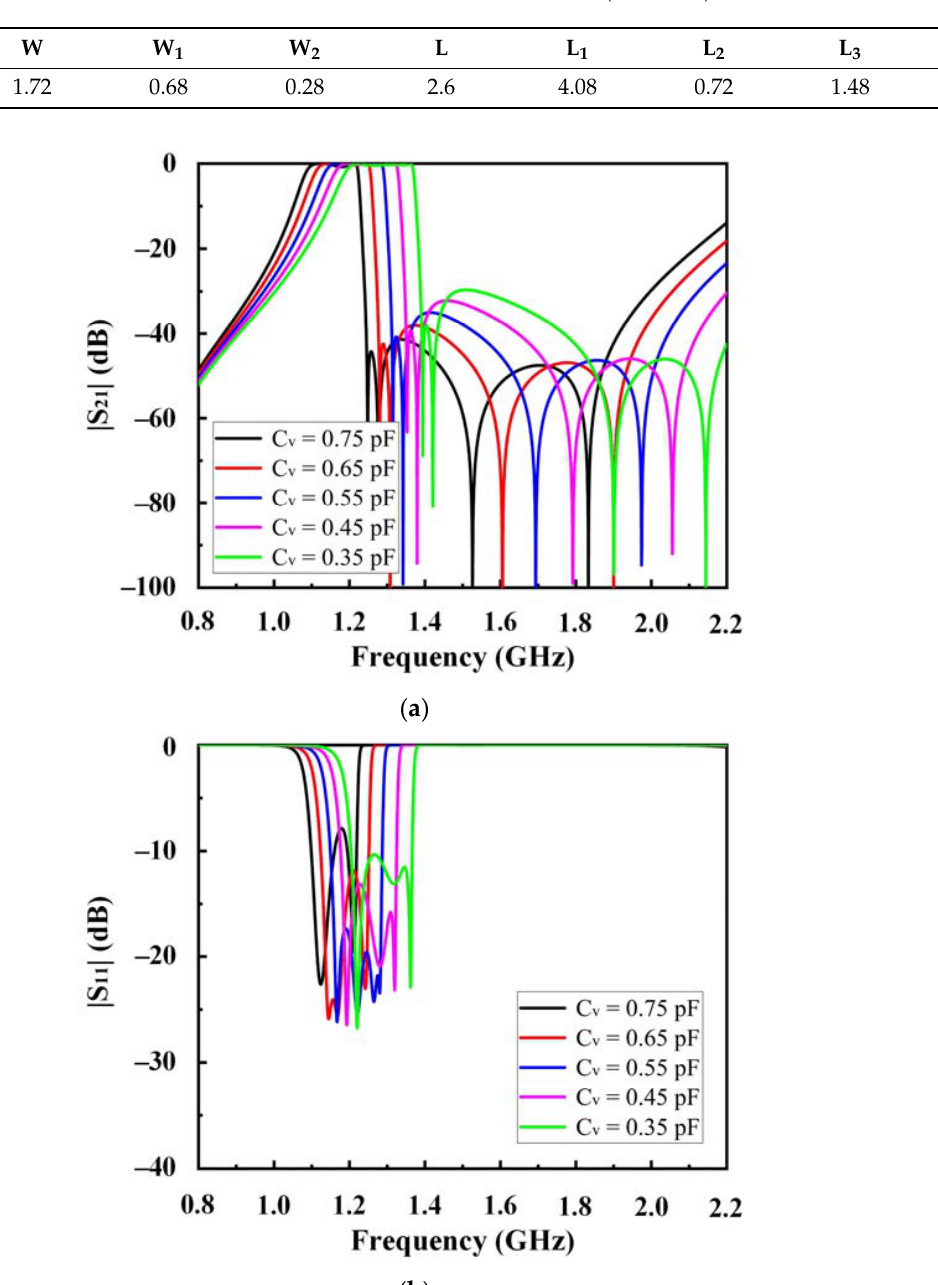
Table 1. Circuit dimensions of the as-fabricated filter (unit: mm).